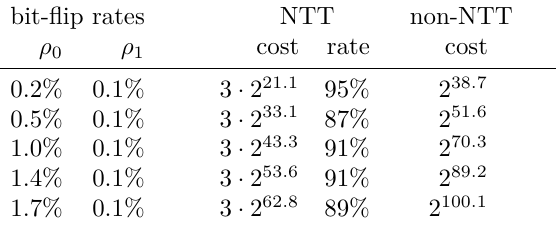
Table 1: Cold boot attacks on Kyber KEM keys stored in the NTT domain with ρ 0 , ρ 1 the cold boot bit-flip rates. The column “cost” gives the cost of recovering 256 components of the secret in terms of the number of lattice points visited during enumeration ( ≈ 100 CPU cycles each). The attack can be repeated to recover all 768 components. The column “rate” shows the overall success rate 1 − (1 − p 0 ) 2 for recovering 256 components of the secret, cf. Section 7. We also give the costs of a cold boot attack when the secret key is stored in the time domain in the column “non-NTT”, cf. Section 4. In that case, the success rate is always expected to be close to 100%. bit-flip rates NTT non-NTT ρ 0 ρ 1 cost rate cost 0.2% 0.1% 3 · 2 21 . 1 95% 2 38 . 7 0.5% 0.1% 3 · 2 33 . 1 87% 2 51 . 6 1.0% 0.1% 3 · 2 43 . 3 91% 2 70 . 3 1.4% 0.1% 3 · 2 53 . 6 91% 2 89 . 2 1.7% 0.1% 3 · 2 62 . 8 89% 2 100 . 1